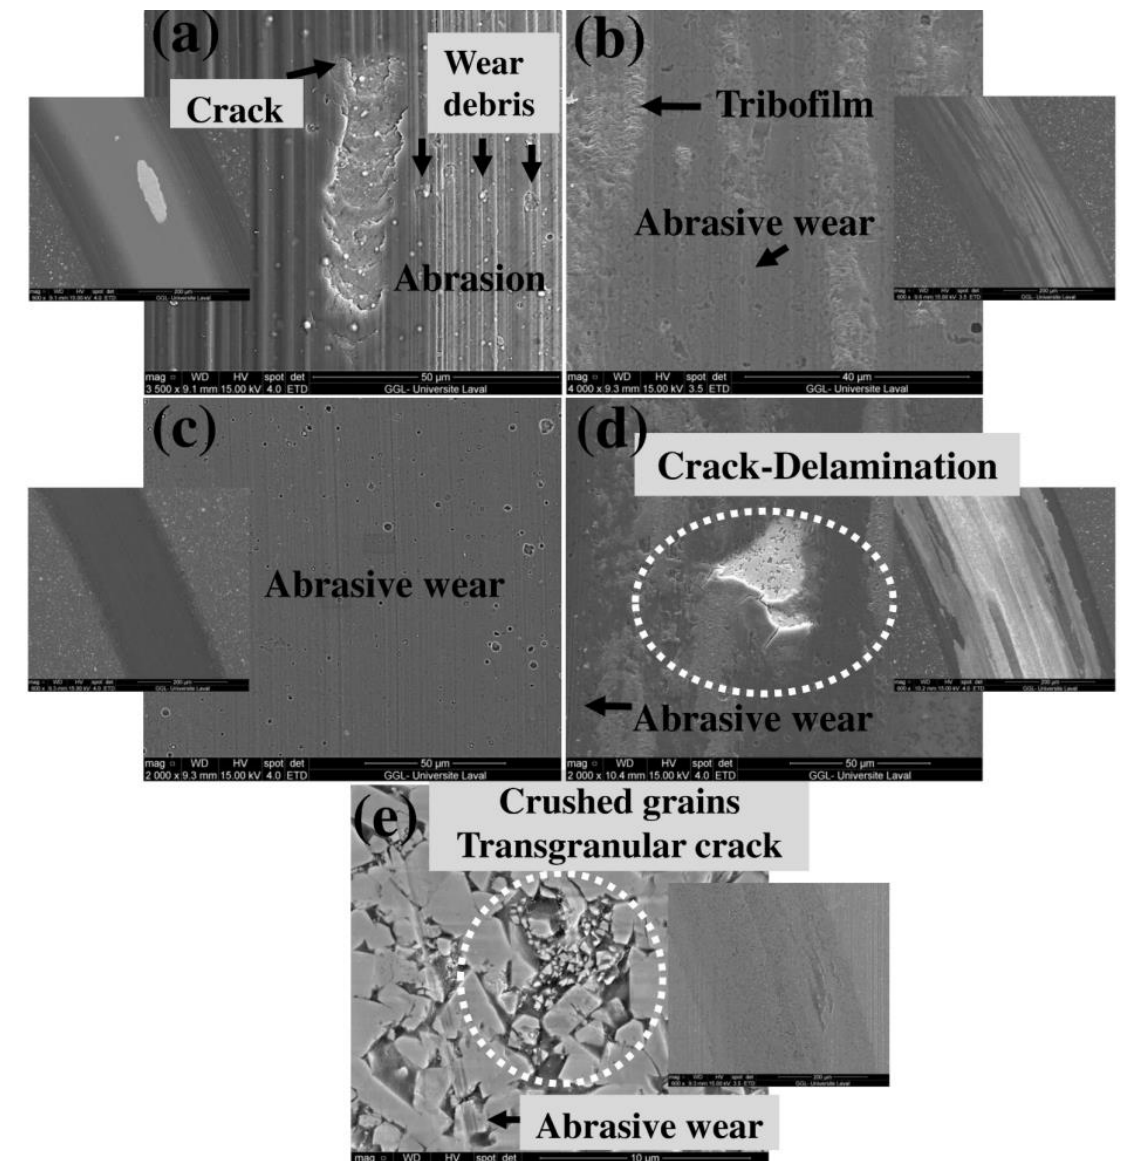
Figure 18. SEM micrographs of the wear track surface of different coatings at the sliding speed of 250 mm/s ( a ) CrN/CrCN/DLC, ( b ) CrN/AlTiN, ( c ) CrN/CrCN, ( d ) CrCN/TiSiCN, and ( e ) uncoated WC-Co substrate.